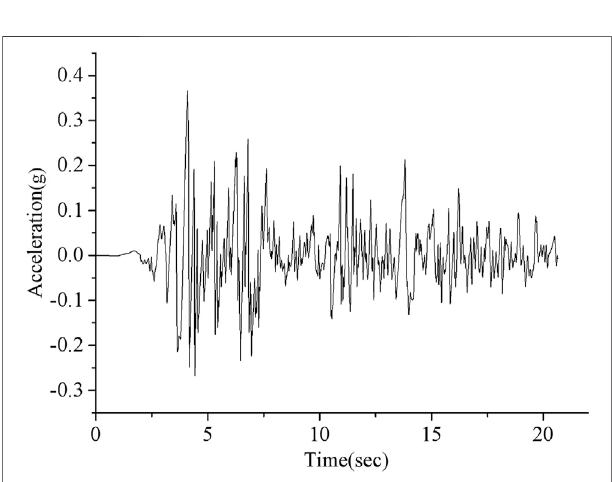
FIGURE 5 | Time-acceleration curve of El Centro